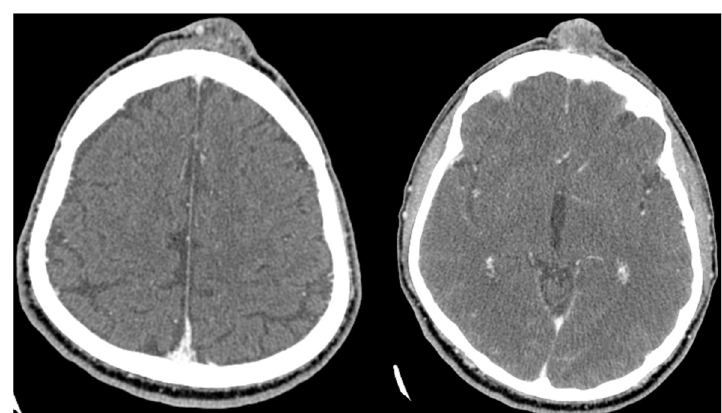
Fig. 3 Imaging of a VM on the forehead of a 55-year-old patient using CT